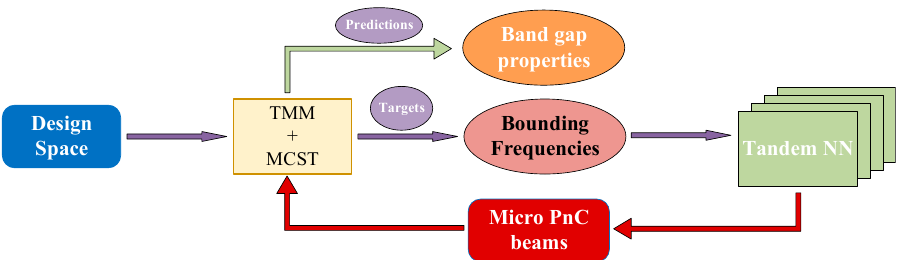
Figure 3. The implement of the inverse design using the MCST and NN models.